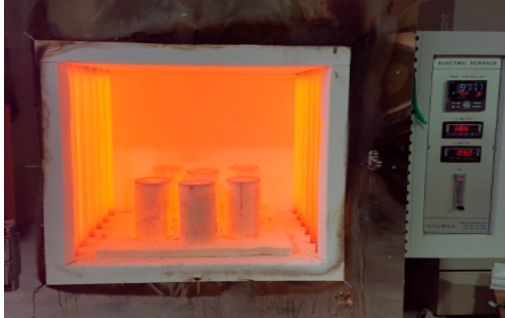
Figure 5. Specimen after exposure to high temperature.